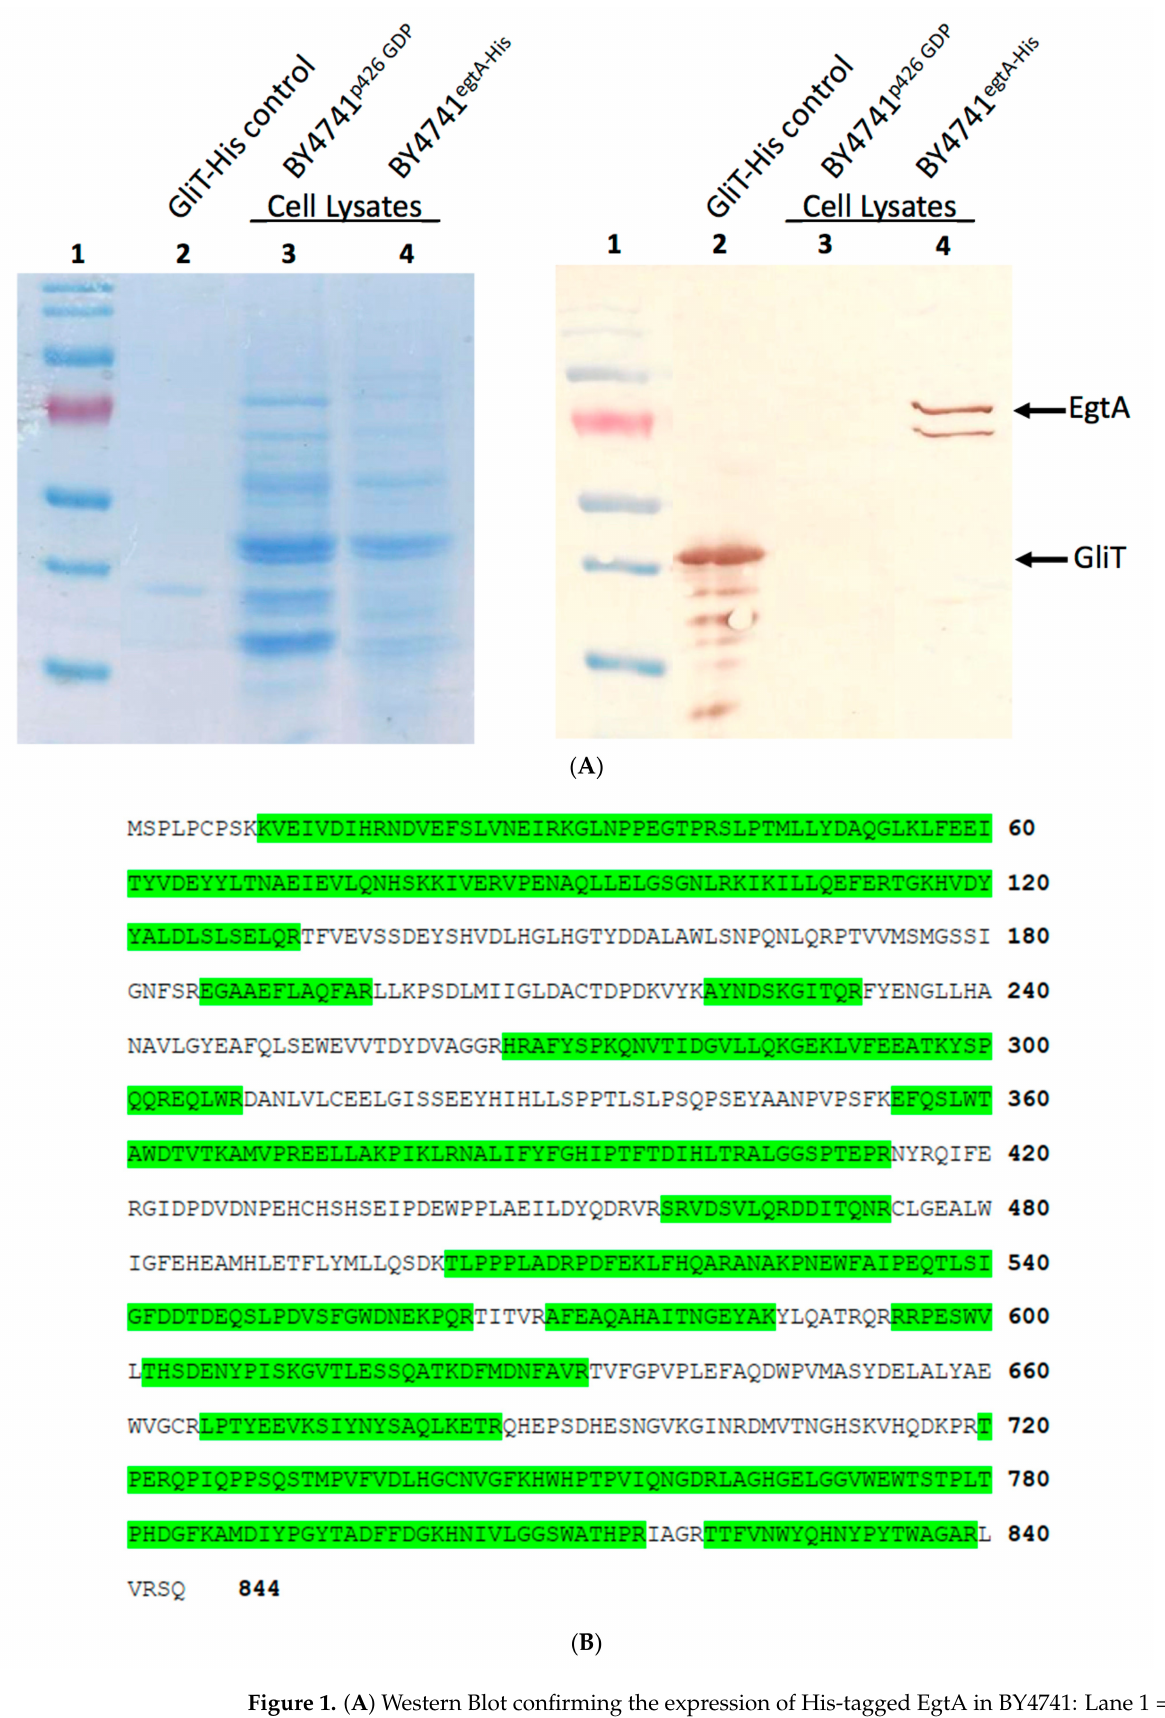
Figure 1. ( A ) Western Blot confirming the expression of His-tagged EgtA in BY4741: Lane 1 =